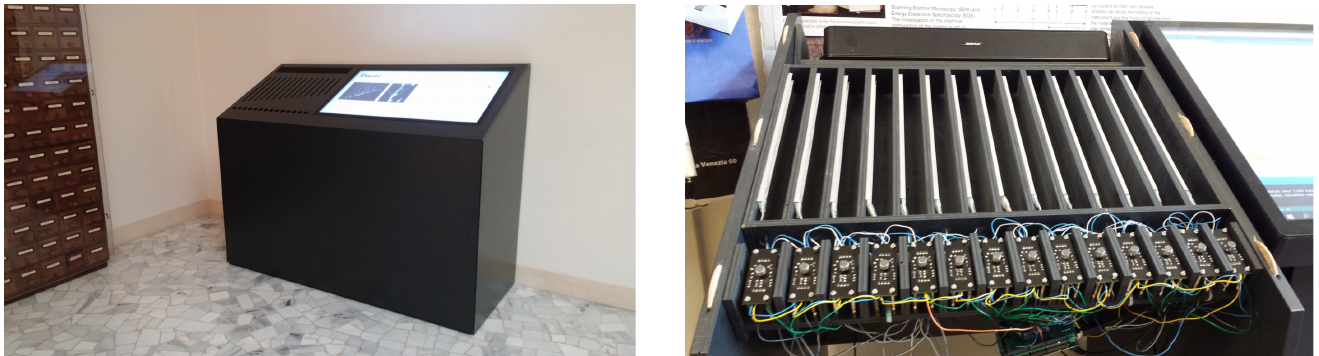
Figure 15. Interactive installation to enhance the viewing experience of the antique Pan flute at the Museum of Archaeological Sciences and Art (MSA) at Padova University: installation in the venue ( left ); details of the blow flute section ( right